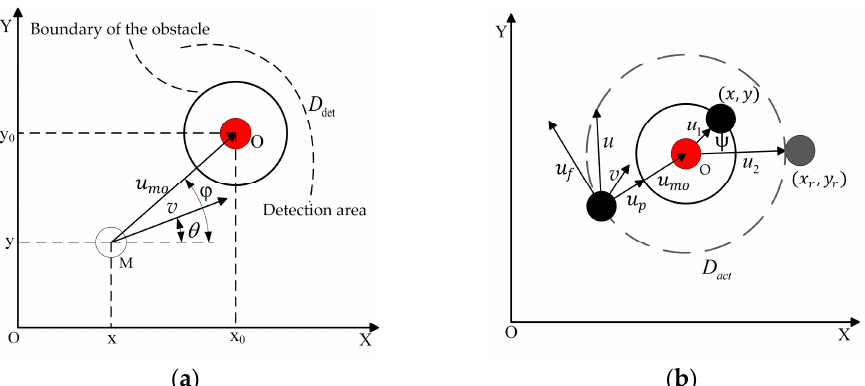
Figure 2. Geometrical relations between the robot and the obstacle: ( a ) The detection of an obstacle; ( b ) The completion of obstacle avoidance.